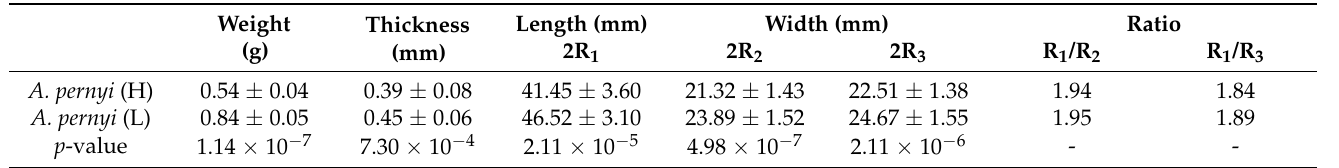
Figure 4. The comparison of the cocoons’ morphology. Table 1. Geometrical parameters of the A. pernyi cocoons from two different source regions (the error in this table is standard deviation).